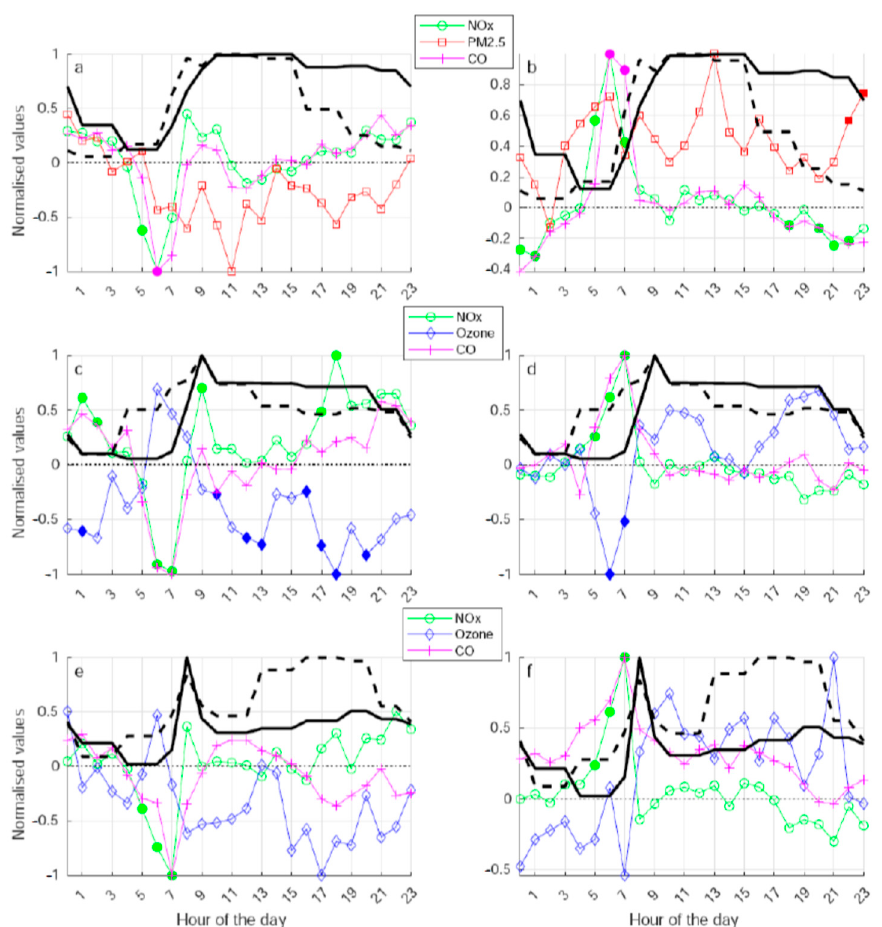
Figure 4. Normalized daily cycles of the DST effect of all the pollutants observed at AQM stations Remez (upper row, subfigures ( a , b )), Bet Shemesh (middle row, subfigures ( c , d )) and Karmiel (lower row, subfigures ( e , f )). Only cycles based on at least 15 years (10 in the case of CO) were considered. Filled markers denote time points where the DST effect was statistically significant at the p = 0.01 level. Normalized daily cycles of car (continuous black line) and truck (dashed black line) volumes near the AQM stations are also shown. Left column: spring DST clock change, and right column: autumn DST clock change.